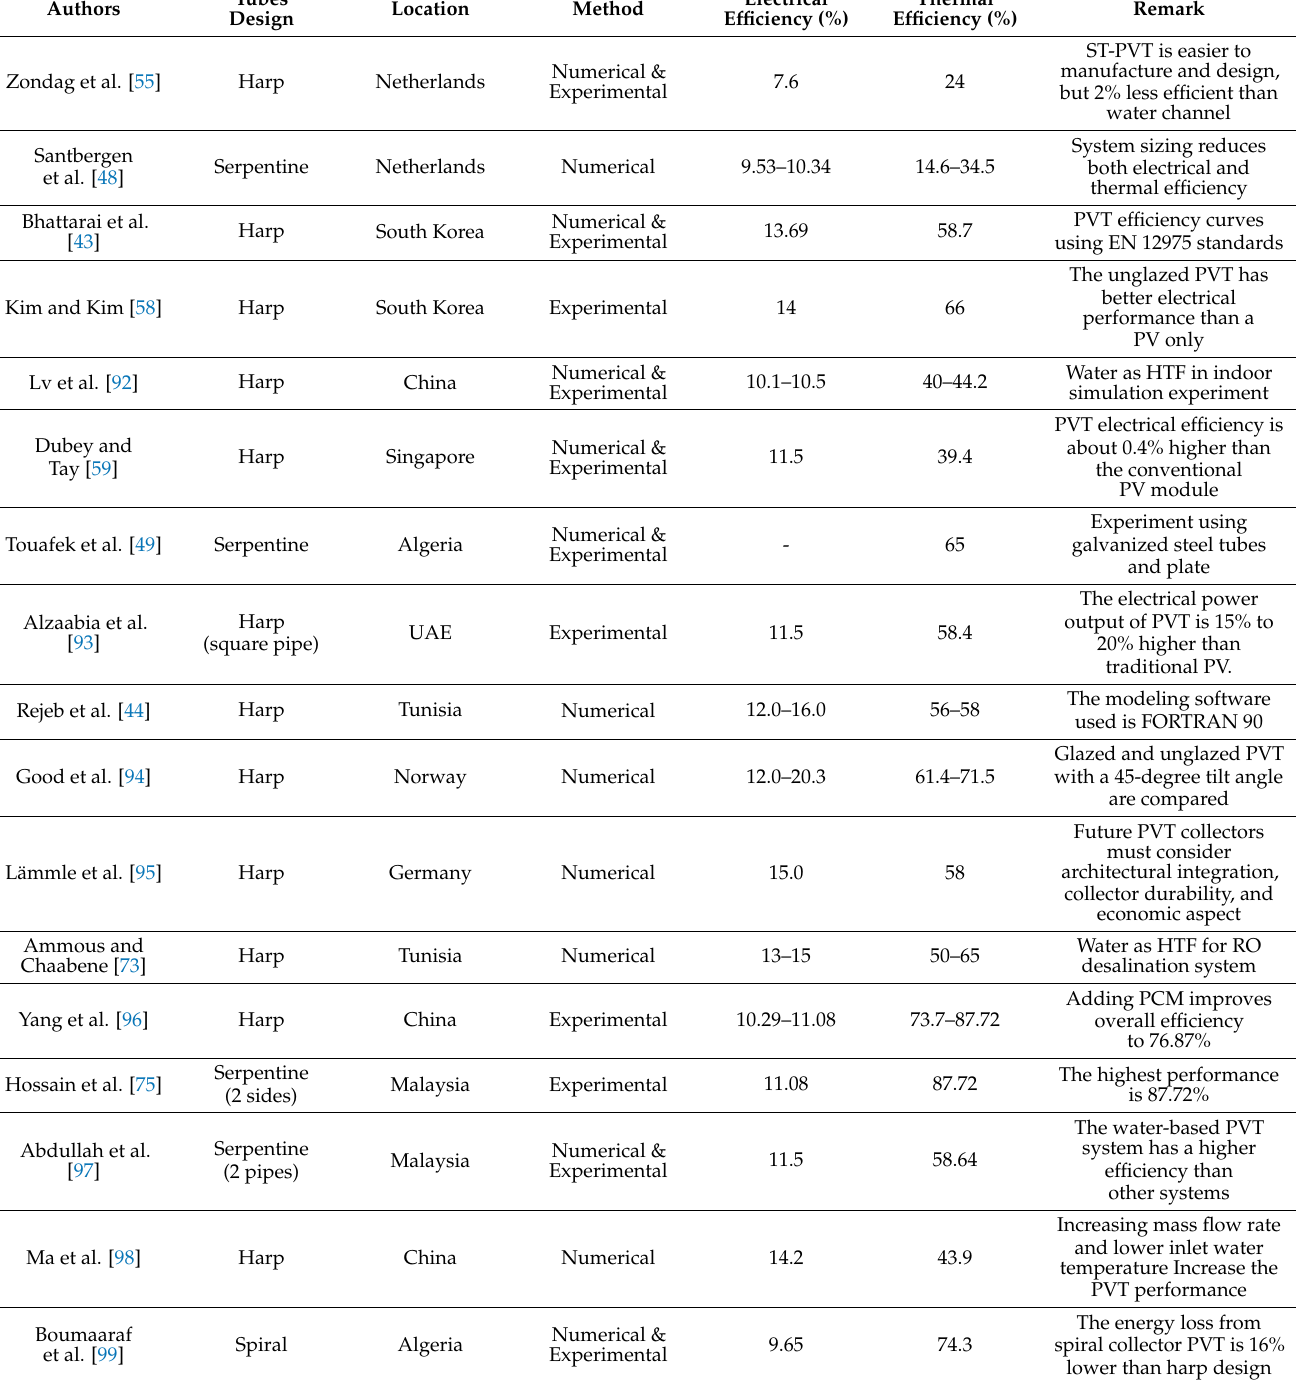
Table 3. Research on PVT with sheet and tube